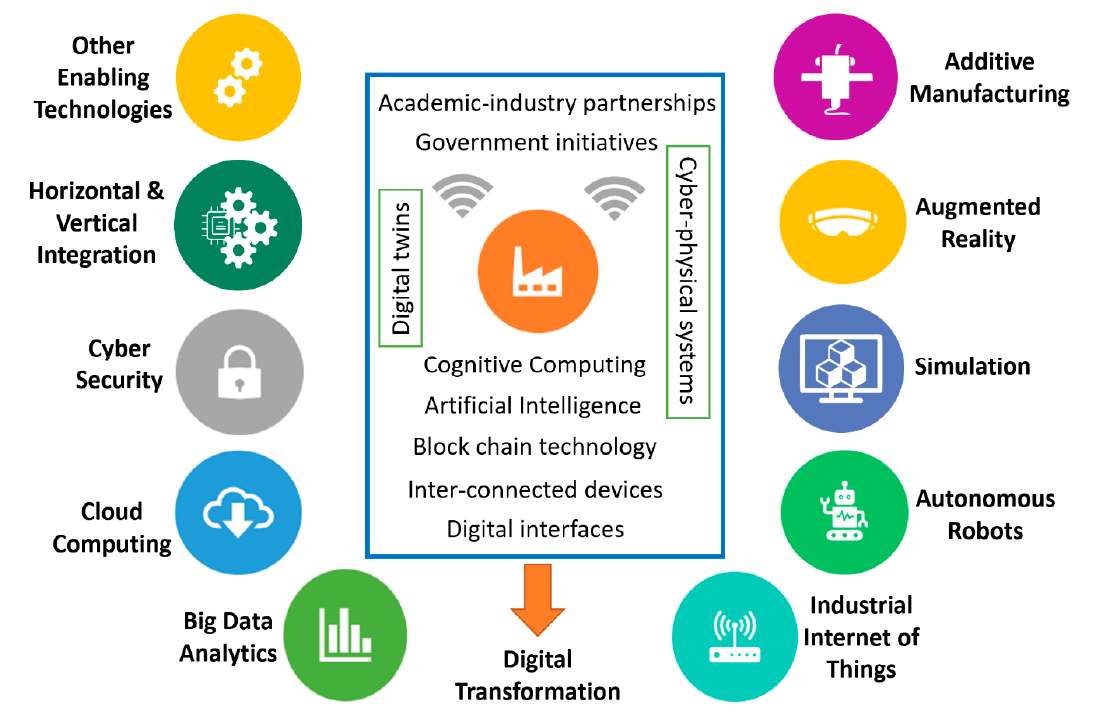
Figure 1. Pillars of Industry 4.0.